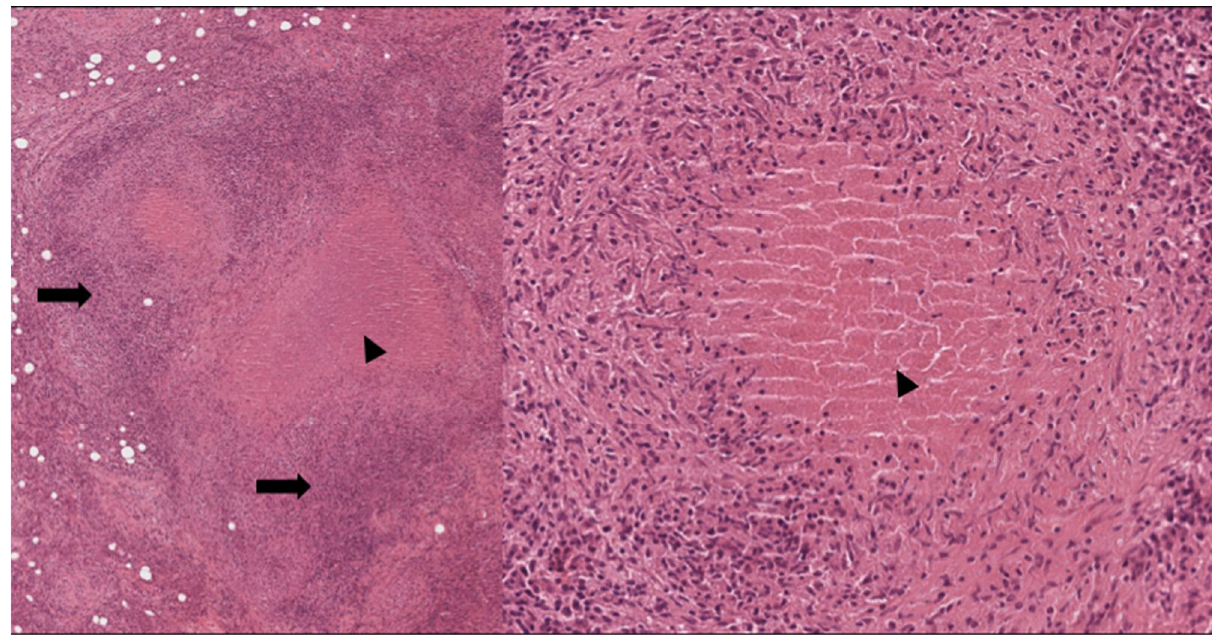
Figure 5. Necrotizing granulomas. Note the central eosinophilic necrosis (arrowhead) and the abundant lymphocytes (arrows); (Left: H&E 40×; right: H&E